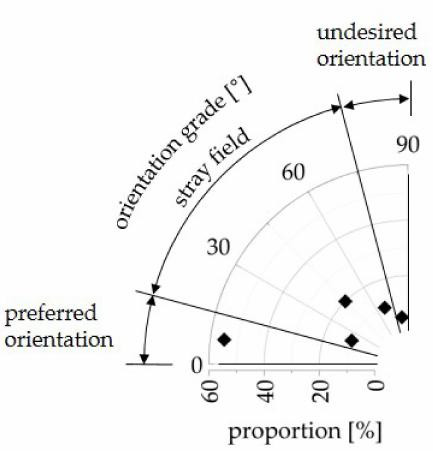
Figure 4. Ideal orientation grade distribution with high proportion in terms of the preferred orienta- tion and low proportion in the other two sectors.